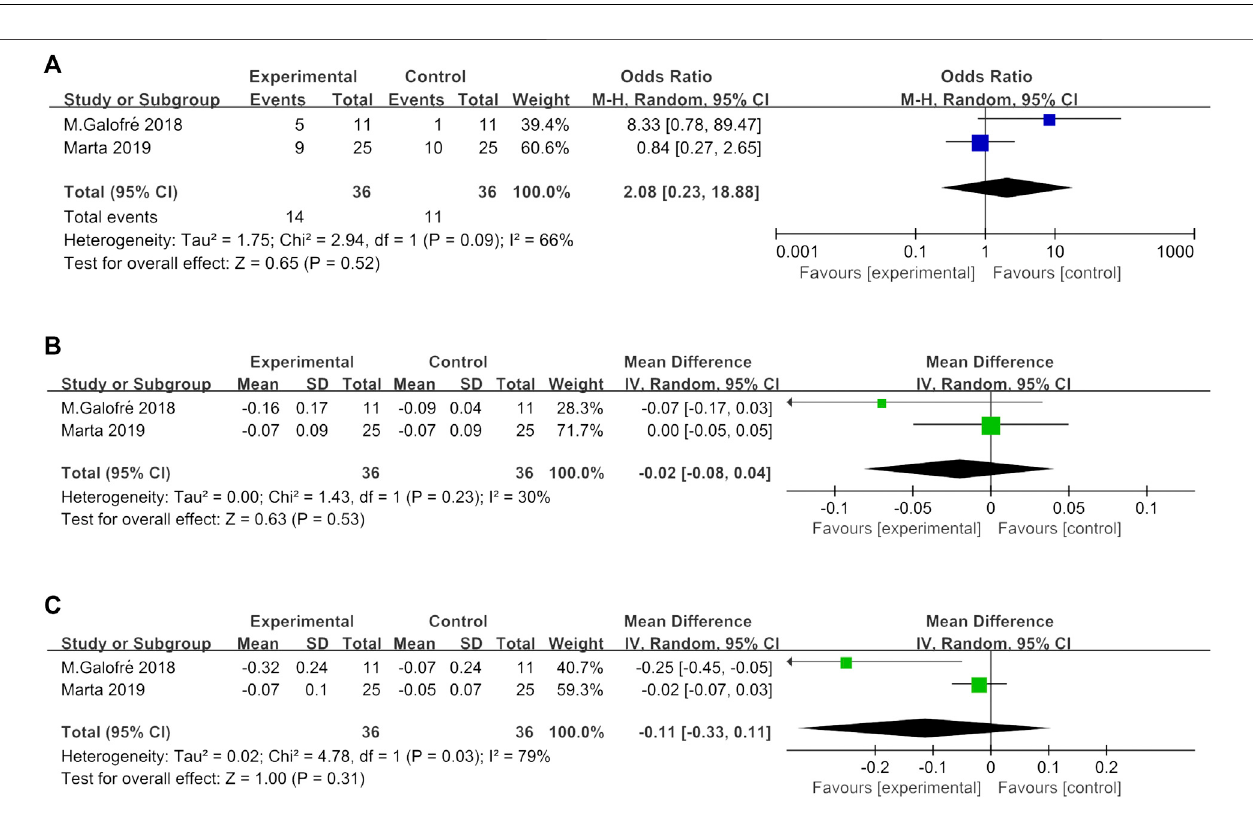
Frontiers in Pharmacology |